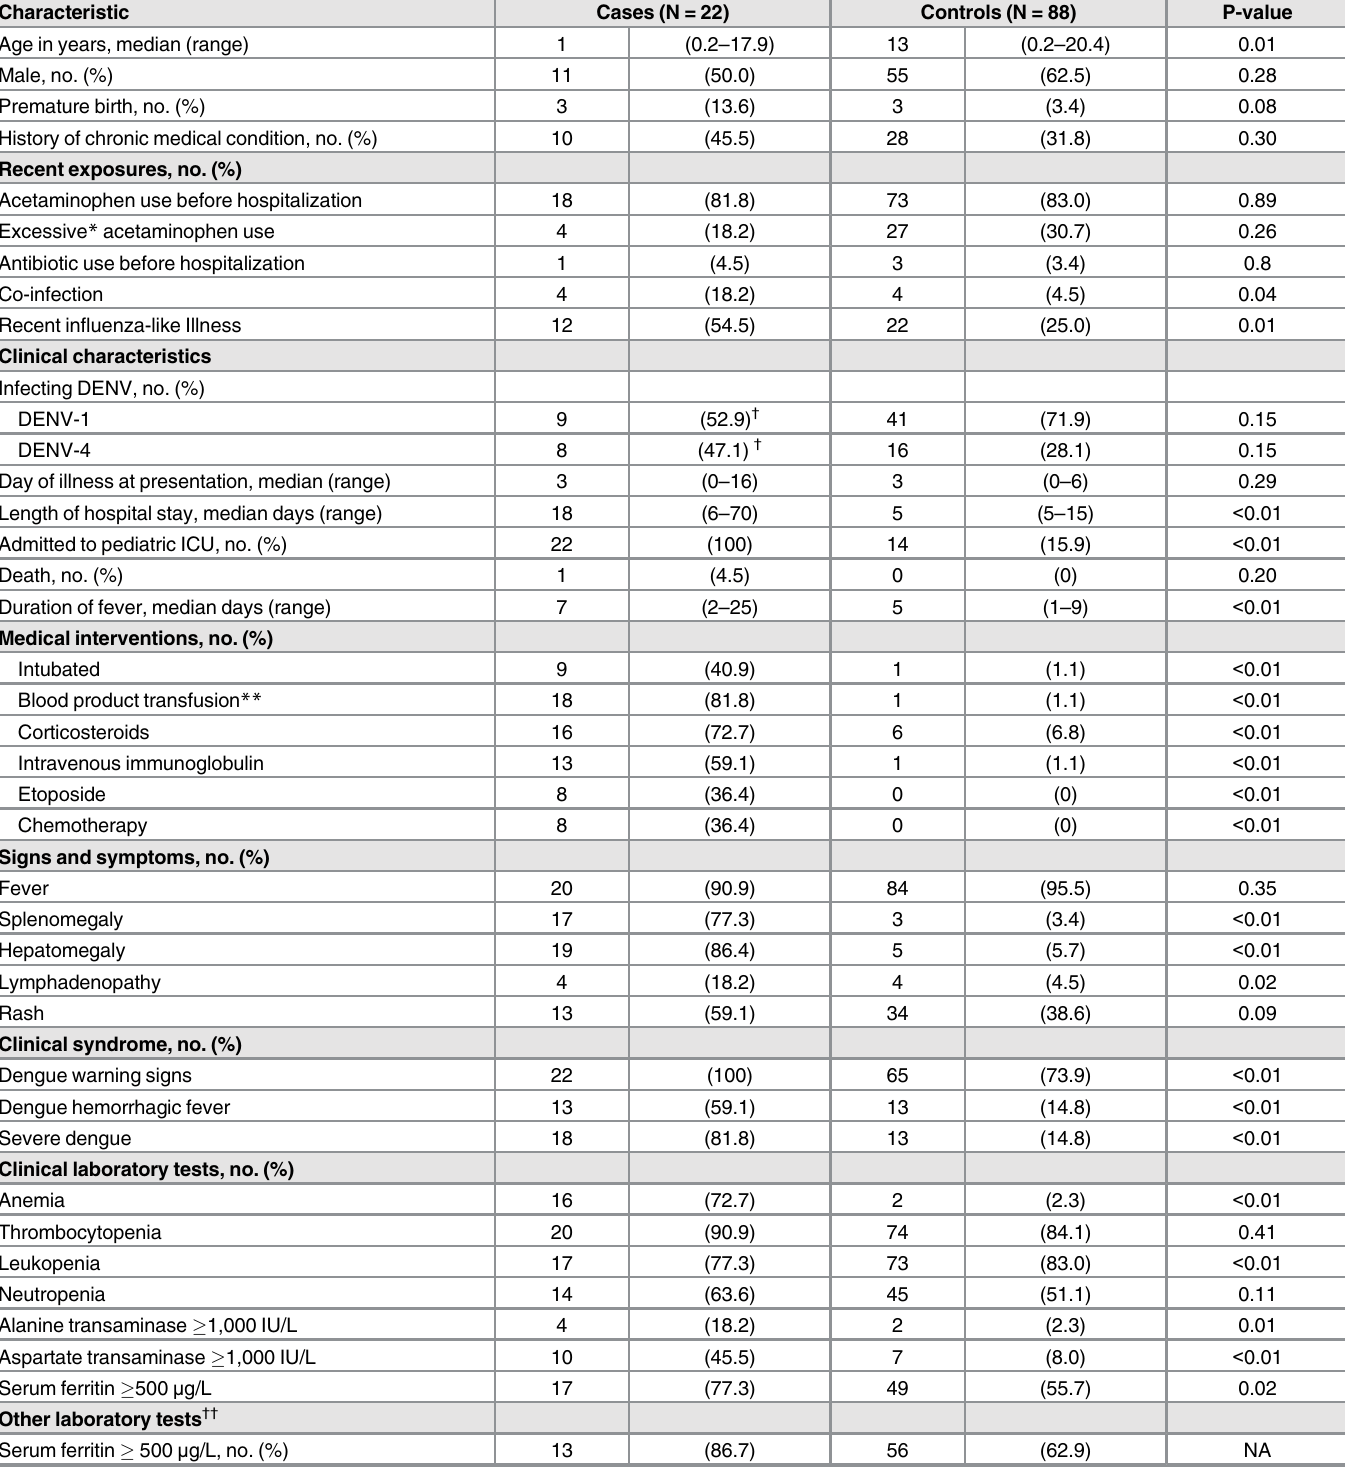
Table 2. Demographic, clinical, and laboratory characteristics of patients with dengue-associated hemophagocytic lymphohistiocytosis (cases) or dengue only (controls) identified in four referral hospitals in Puerto Rico during January 2008 through June 2013.